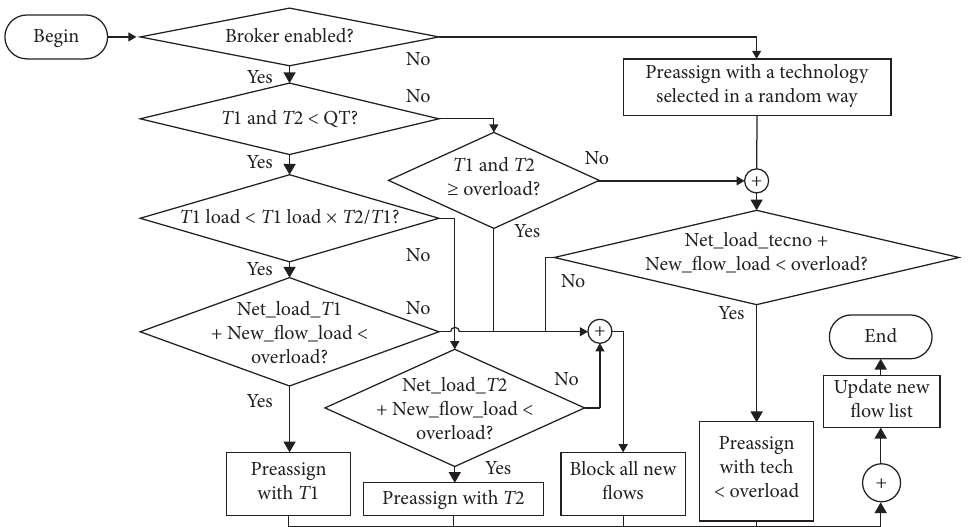
Figure 3: Network selection and flow